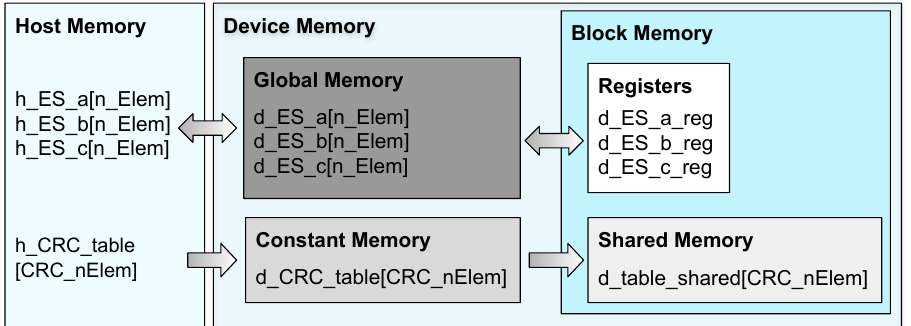
Figure 3. ES transference among GPU memory hierarchies ( CRC _ nElem : number of CRC lookup table memory addresses. n _ Elem : number of ES memory